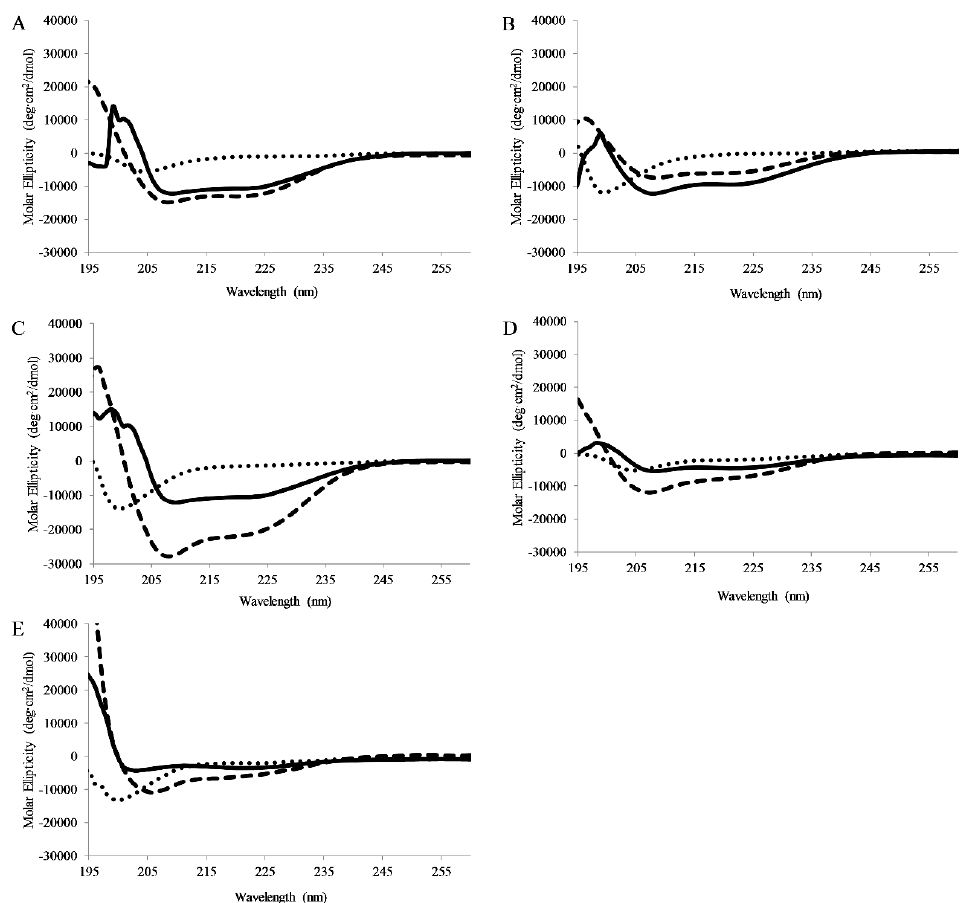
Figure 4. Circular Dichroism Spectroscopy: Circular dichroism spectra of 5 µ M ( A ) AP3, ( B ) AP3K, ( C ) APX, ( D ) APX-17, or ( E ) APX-12 Spectra were recorded in the presence of pH7 buffer, 1:1 TFE:pH7 buffer, or 250 µ M 75:25 PC:PG SUVs. For all graphs, peptide in buffer is shown as dots, peptide in buffer:TFE as dashes, and peptide with Lipid vesicles as solid lines. All spectra are averages of 64 scans and were background subtracted.